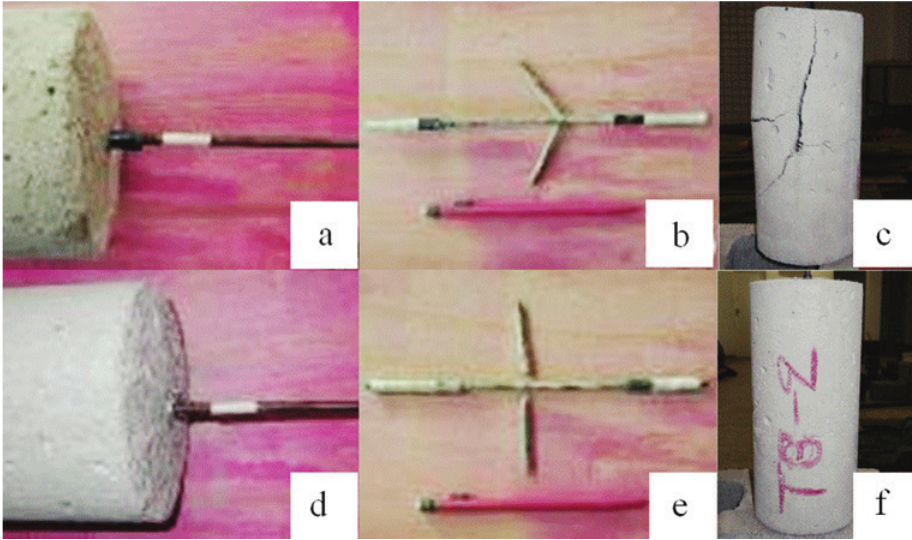
Nota: para 78% da amostra, deslizamento da barra longitudinal com dobramento da barra transversal (a, b) provocando a fissuração longitudinal e transversal do cilindro de concreto (c). Para 22 % da amostra, ruptura ao nível da solda ligando a barra longitudinal com a barra transversal (d, e), sem provocar fissuras no cilindro de concreto Figura 8 Modos de ruptura da amostra AT2